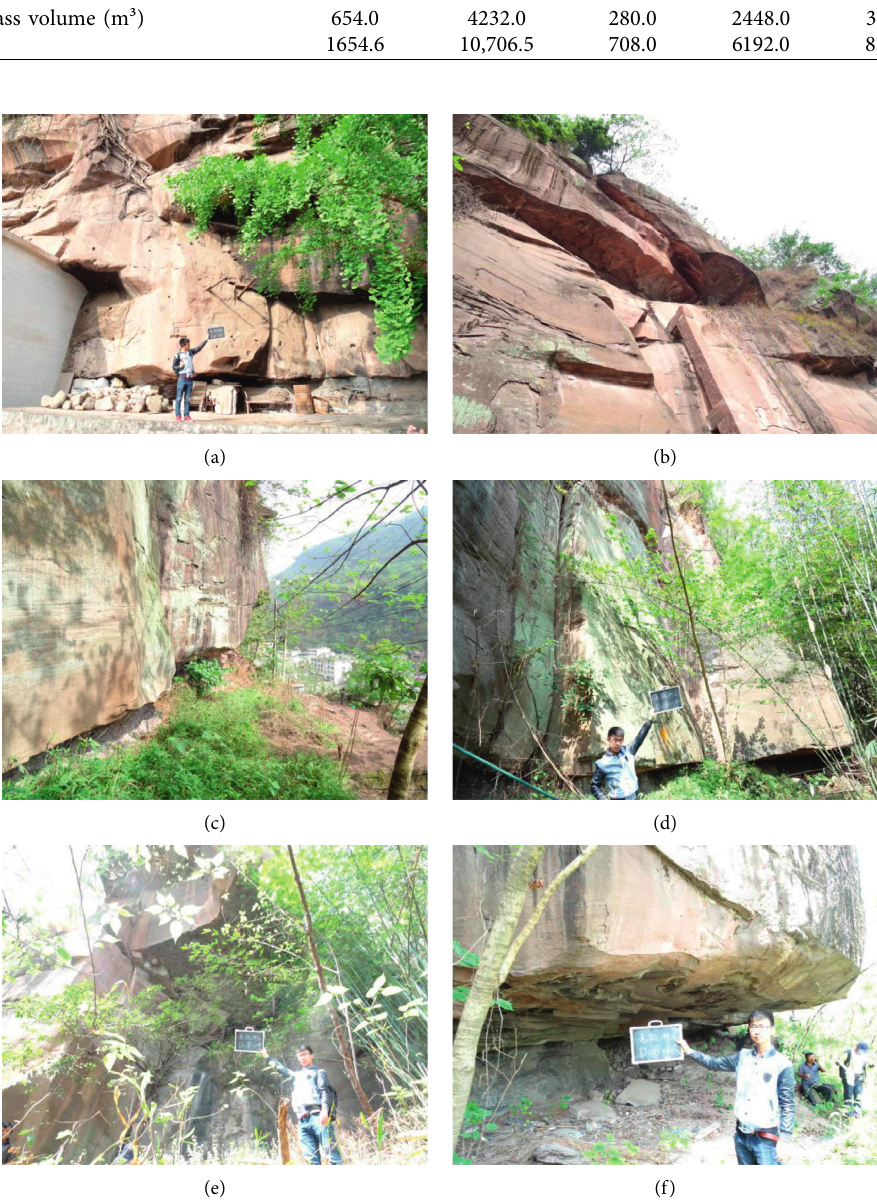
Figure 4: Photographs of dangerous rocks. (a) W 1 dangerous rock mass. (b) W 2 dangerous rock mass. (c) W 3 dangerous rock mass. (d) W 4 dangerous rock mass. (e) W 5 dangerous rock mass. (f) W 6 dangerous rock